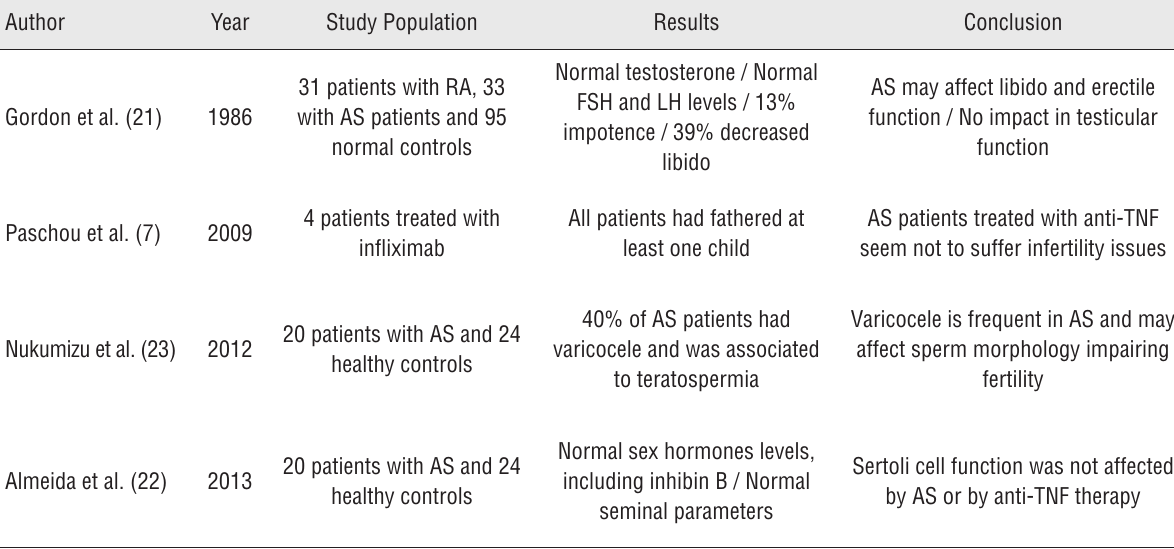
Table 4 – ankylosing spondylitis and male